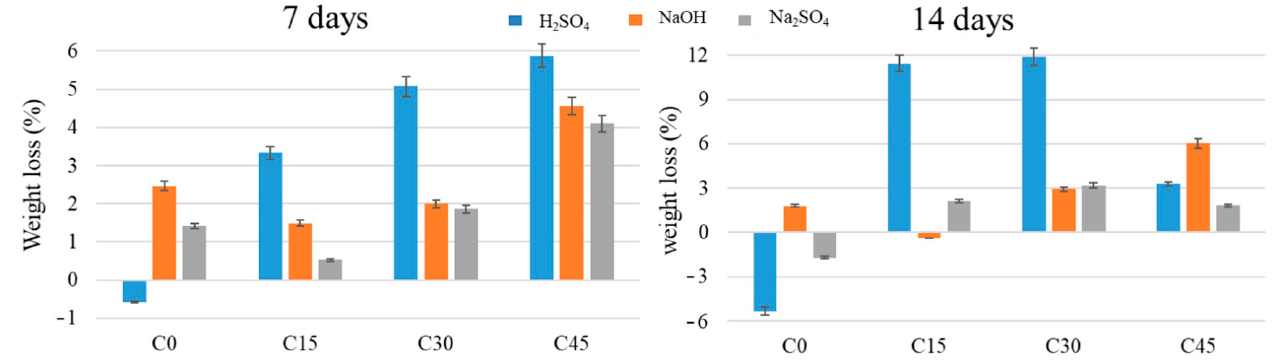
Figure 13 . Mass changes of Portland cement samples containing waste in different proportions after immersion in corrosive media after 7 and 14 days.